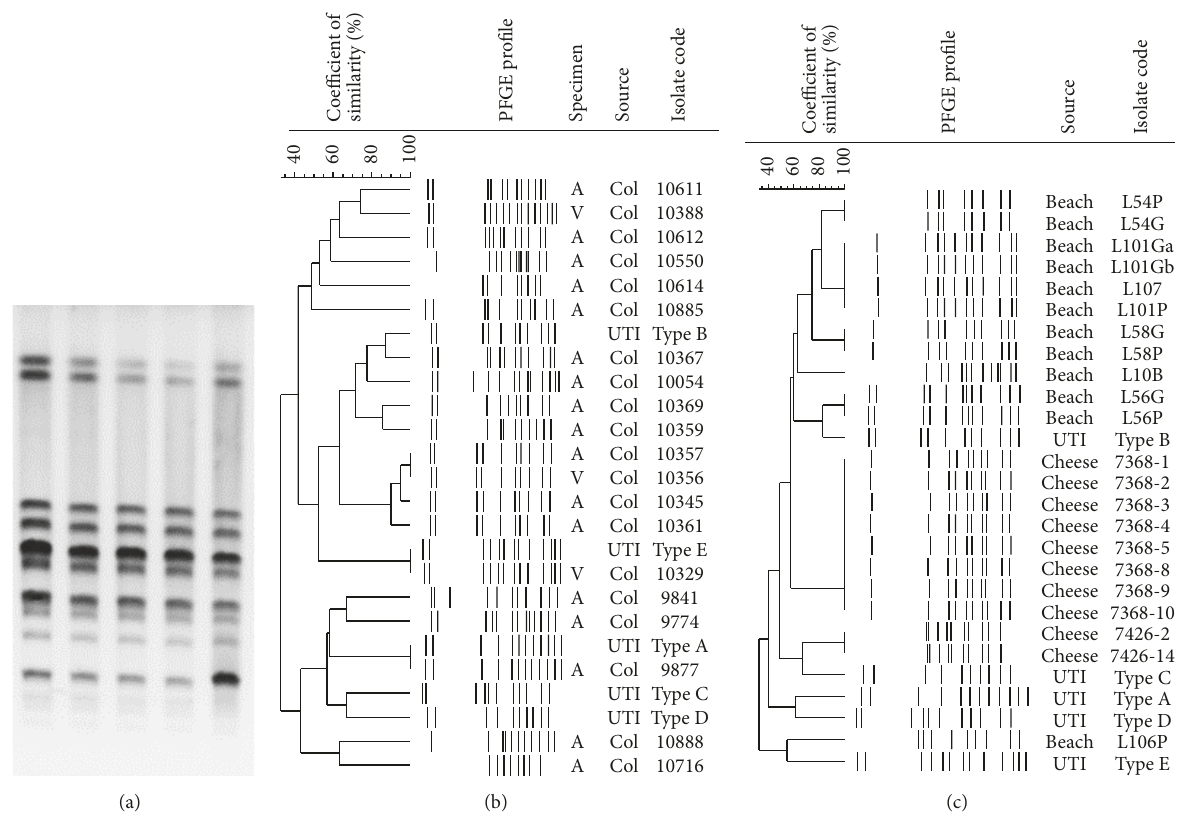
Figure 2: Pulsed-field gel electrophoresis profiles of the Staphylococcus saprophyticus isolates obtained from pregnant women, minas cheese, and beach waters of Rio de Janeiro. PFGE band patterns of (a) five isolates obtained from the microbiota of a single pregnant women; (b) comparison of the five uropathogenic PFGE clusters with one isolate per pregnant woman ( 𝑛 = 21 ) and (c) 10 isolates from minas cheese and 12 from beach waters. “A”: anal; “V”: